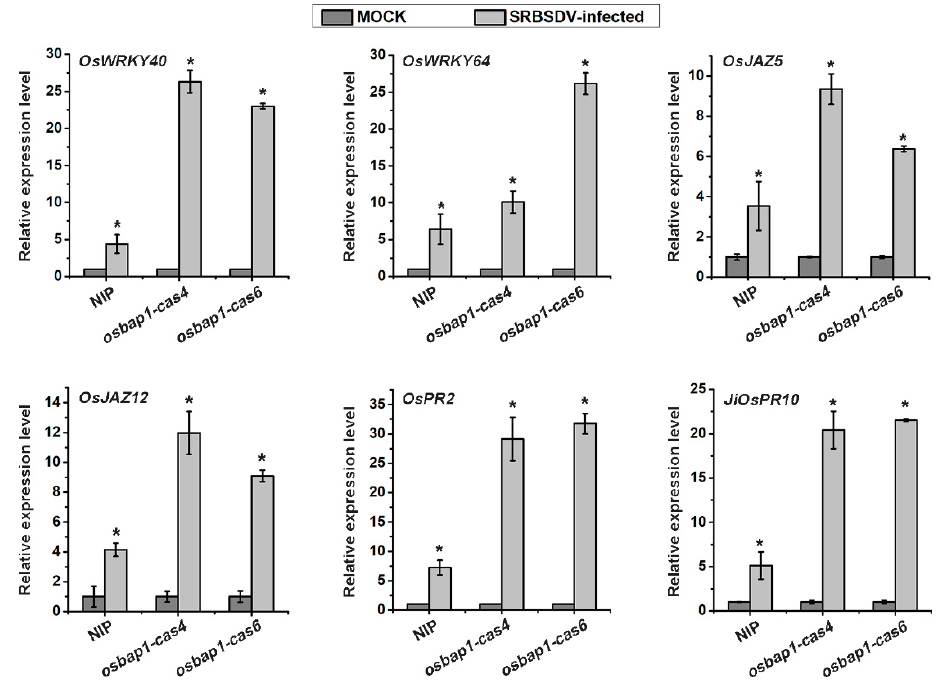
Figure 6. RT-qPCR assays to verify the expression levels of six defense-related genes in SRBSDV- infected NIP and OsBAP1 mutant plants. UBQ5 was used as the internal reference gene to normalize the relative expression. Values are the means ± SD from 3 biologically independent samples. * at the top of columns indicates significant differences ( p -value ≤ 0.05) based on Fisher’s least significant difference tests.